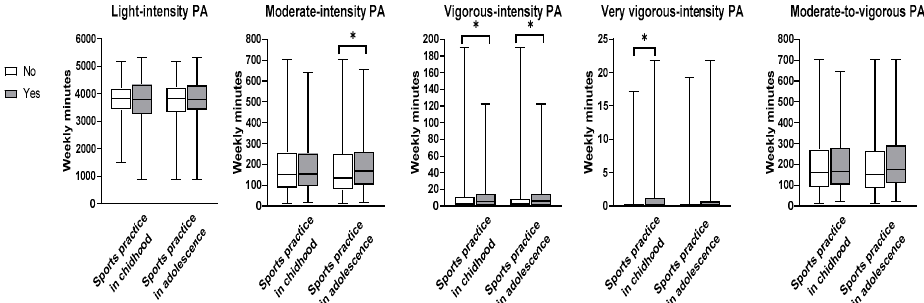
Figure 1. Physical activity intensities according to early sports practice in childhood and adolescence among community-dwelling adults (n = 264). * Statistical significance at p < 0.05 level.